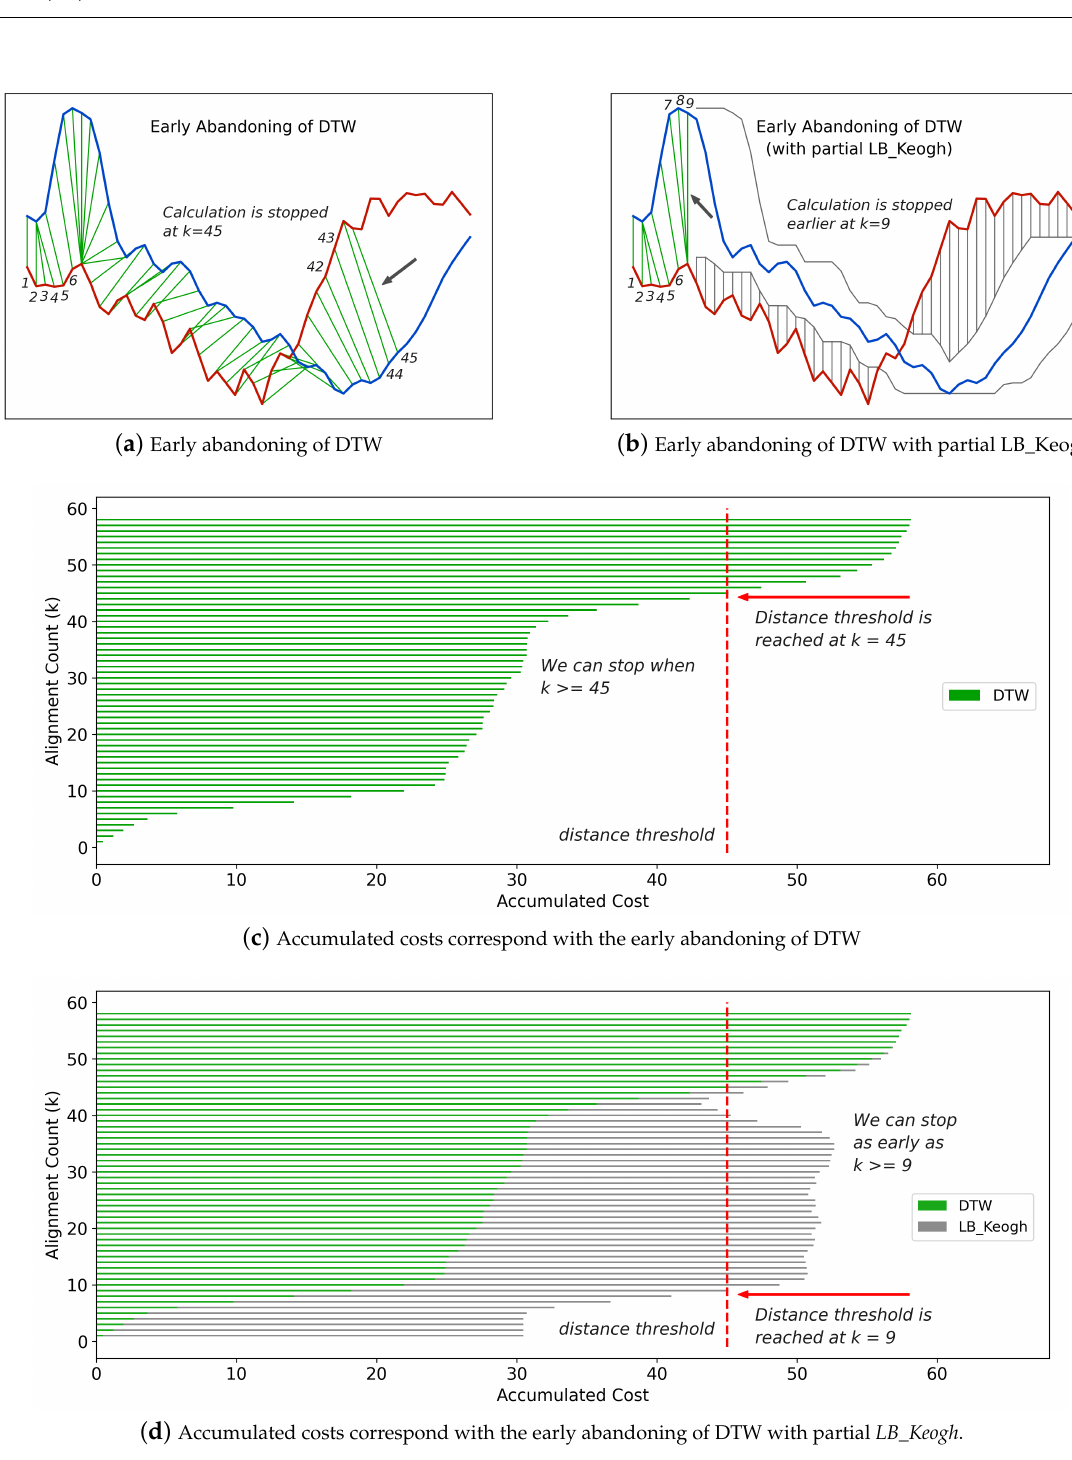
Figure 4. Examples of early abandoning of DTW with and without partial LB_Keogh . The green lines indicate the alignments of DTW, and the gray lines indicate the alignments of LB_Keogh . k is the counter of steps. The numbers in subfigure ( a , b ) are ordinal numbers of